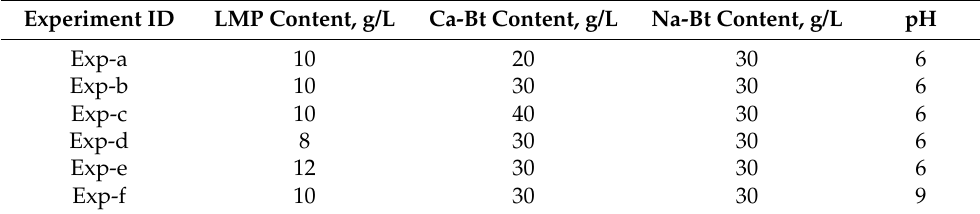
Table 11. Single factor experiment settings with different composition ratios.